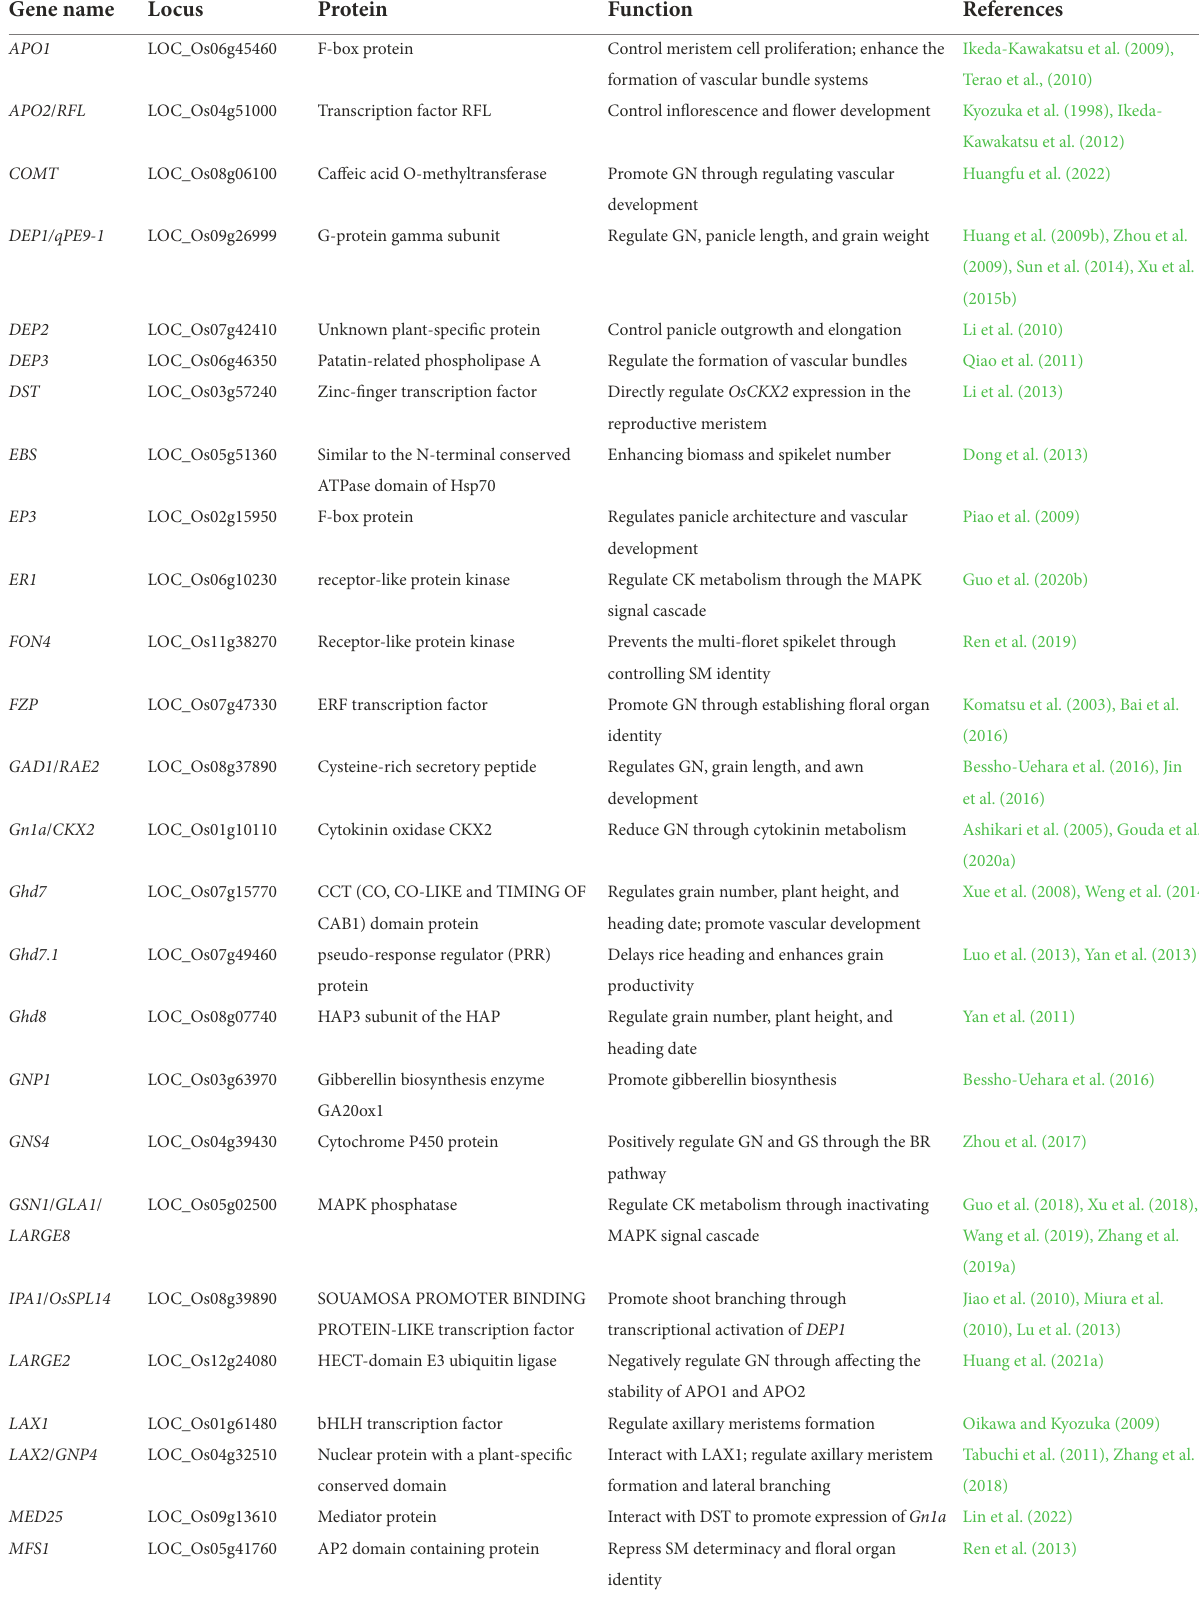
TABLE 1 List of the genes involved in rice grain number per panicle